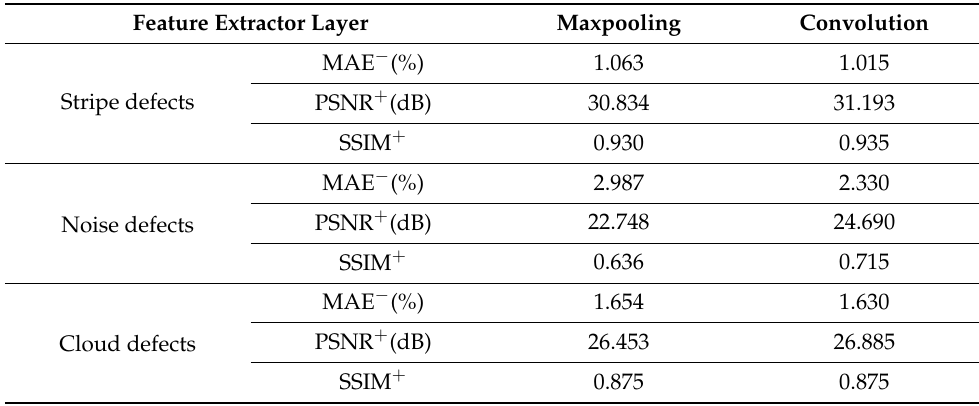
Table 11. Inpainting Quality Comparison of Different Extractor